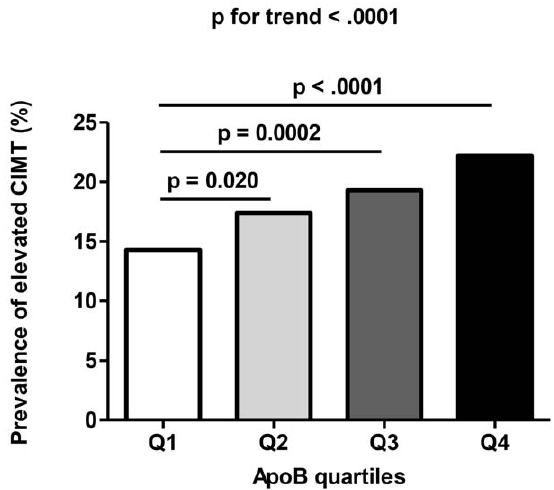
Figure 1. Prevalence of elevated CIMT in different quartiles of apoB: quartile 1 (Q1, n=167), 0–0.78 g/L; quartile 2 (Q2, n=216), 0.78–0.92 g/L; quartile 3 (Q3, n=257), 0.92–1.08 g/L; quartile 4 (Q4, n=298), . 1.08 g/L.